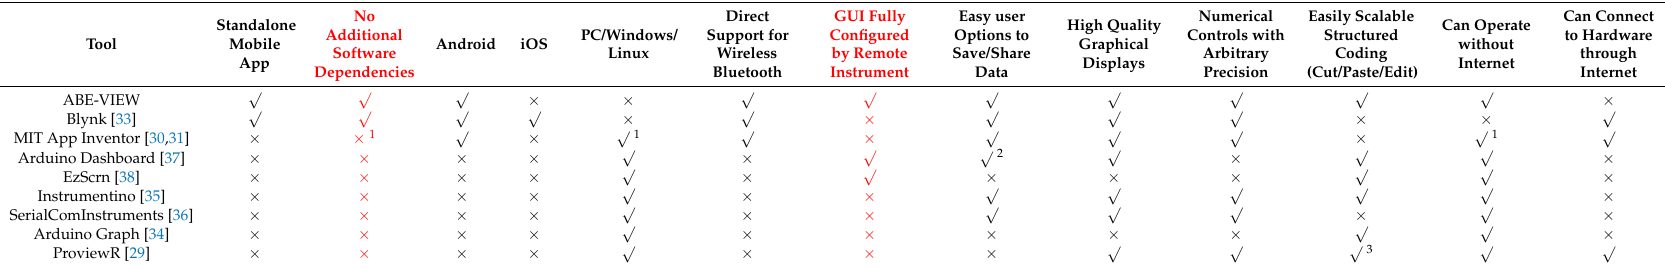
Table 1. Comparison of ABE-VIEW features to alternative software for GUI development for custom hardware. The key features that we believe facilitate use by inexperienced developers are flagged in